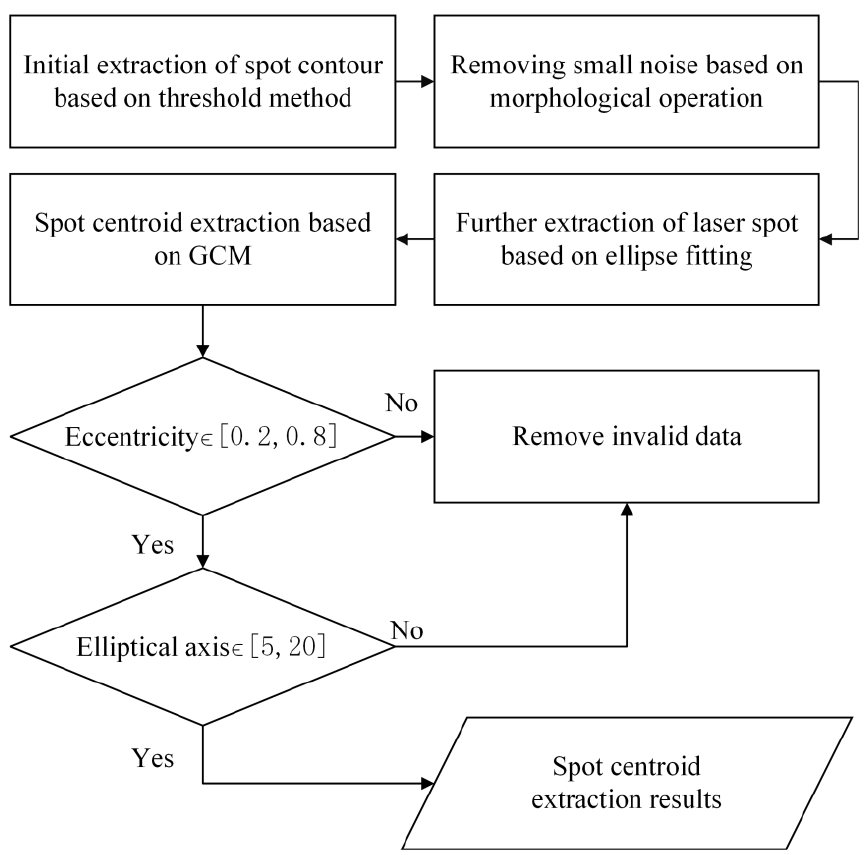
Figure 2. Flowchart of the ellipse-fitting method (TEFM) algorithm. Remove the influence of background objects. Extract the slice of the LFI where the laser spot is located. Each pixel can be regarded as the superposition effect of the spot and ground object. After extensive statistical analysis, it was found that the histogram of the gray distribution in the background area tends to range from 2000 to 3000. The image is sliced to remove the influence of ground objects. We then subtracted 2000 from the overall gray value amplitude, as shown in Figure 2a. Preliminary extraction of the laser spot contour based on the threshold method. Equation (1) was used to calculate the threshold value, T , and determine the initial extraction result of the light spot. As the first constraint, pixels smaller than the threshold value were assigned as 0. I ( i,j ) represents the gray value of the i th row and j th column in the image, and M and N represent the maximum and minimum values of the image rows and columns, respectively. Figure 3b shows the processing results, where some cloud areas are misidentified.